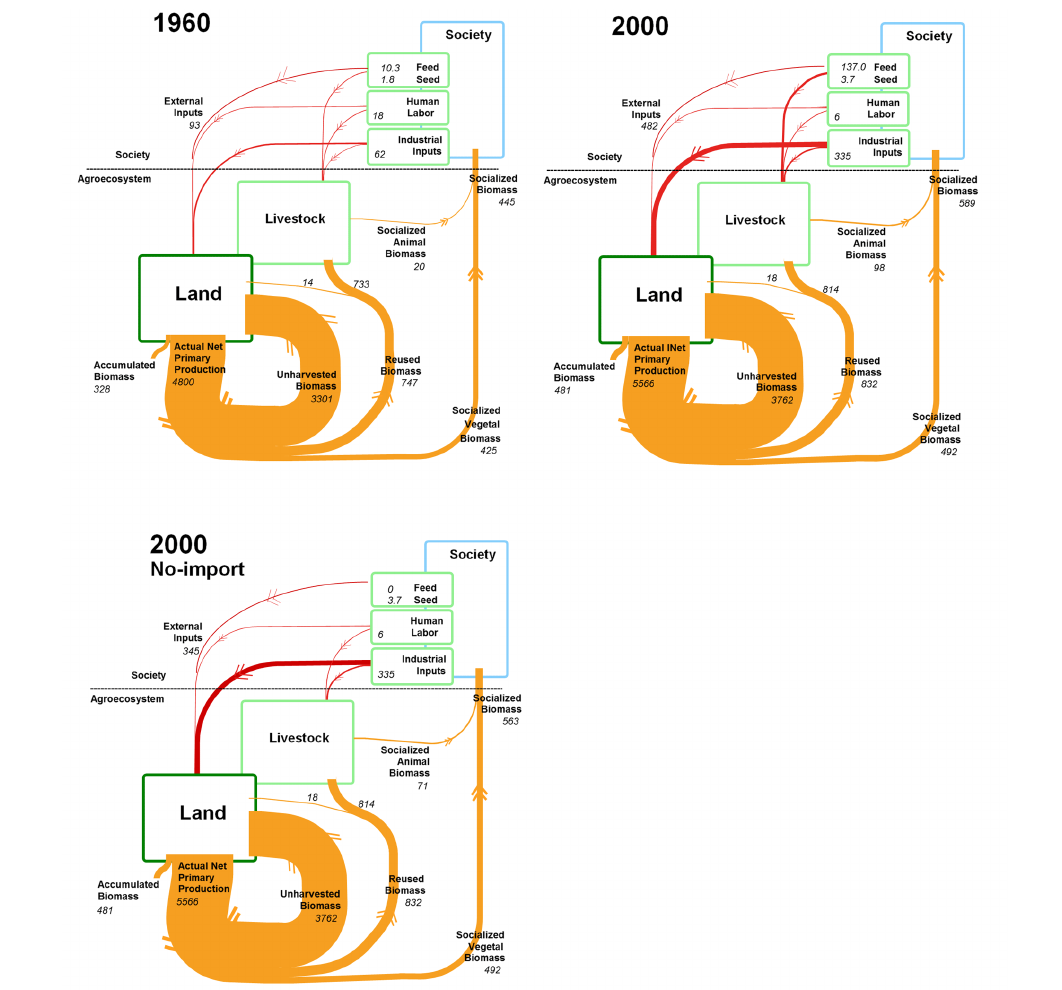
Fig. 1 . Energy flows in Spanish agroecosystem in 1960, 2000, and no-import scenario (in